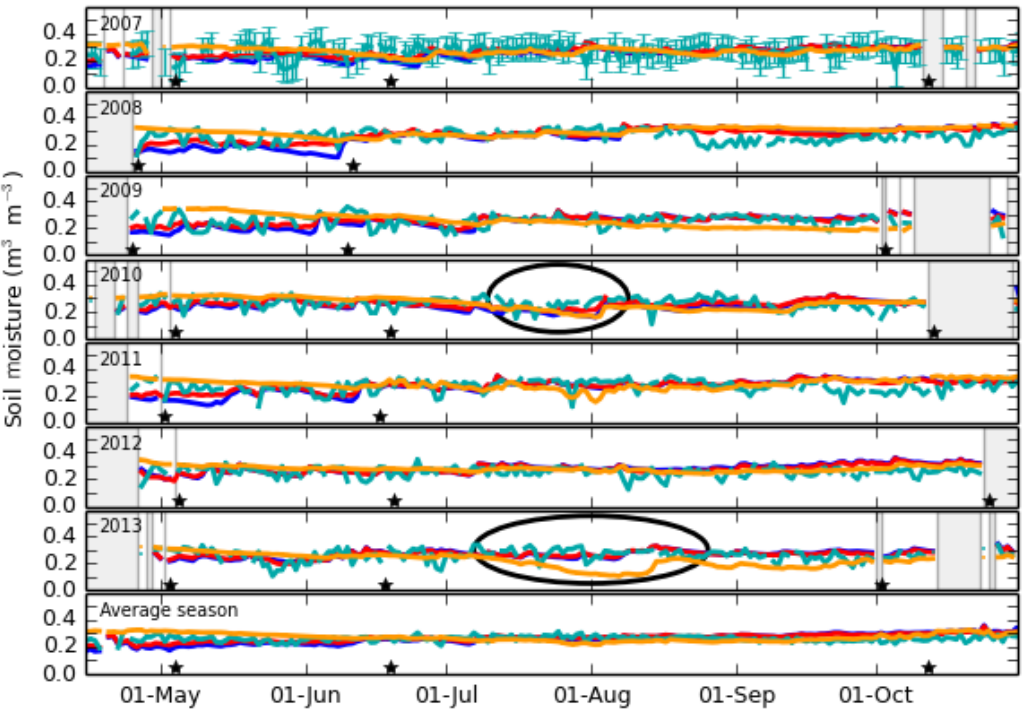
Figure 5. Time series of soil moisture in SiBCASA original (without assimilation) (blue), and with assimilation (red), in situ soil moisture (orange), and ASCAT soil moisture (marine) in Hyytiälä, Finland. Each panel shows 1 year of soil moisture. Grey shades indicate periods when the top soil is frozen. The three asterisks indicate the date when the top soil is last frozen in the spring, 46 days after that, and the date when the top soil is first frozen again in the fall. Error bars in the top panel indicate the uncertainty in ASCAT soil moisture, which is for clarity only shown for 1 year. The bottom panel shows the average seasonal cycle of the each soil moisture type. In situ and ASCAT soil moisture are CDF-matched to SiBCASA soil moisture, which explains why they have the same mean and standard